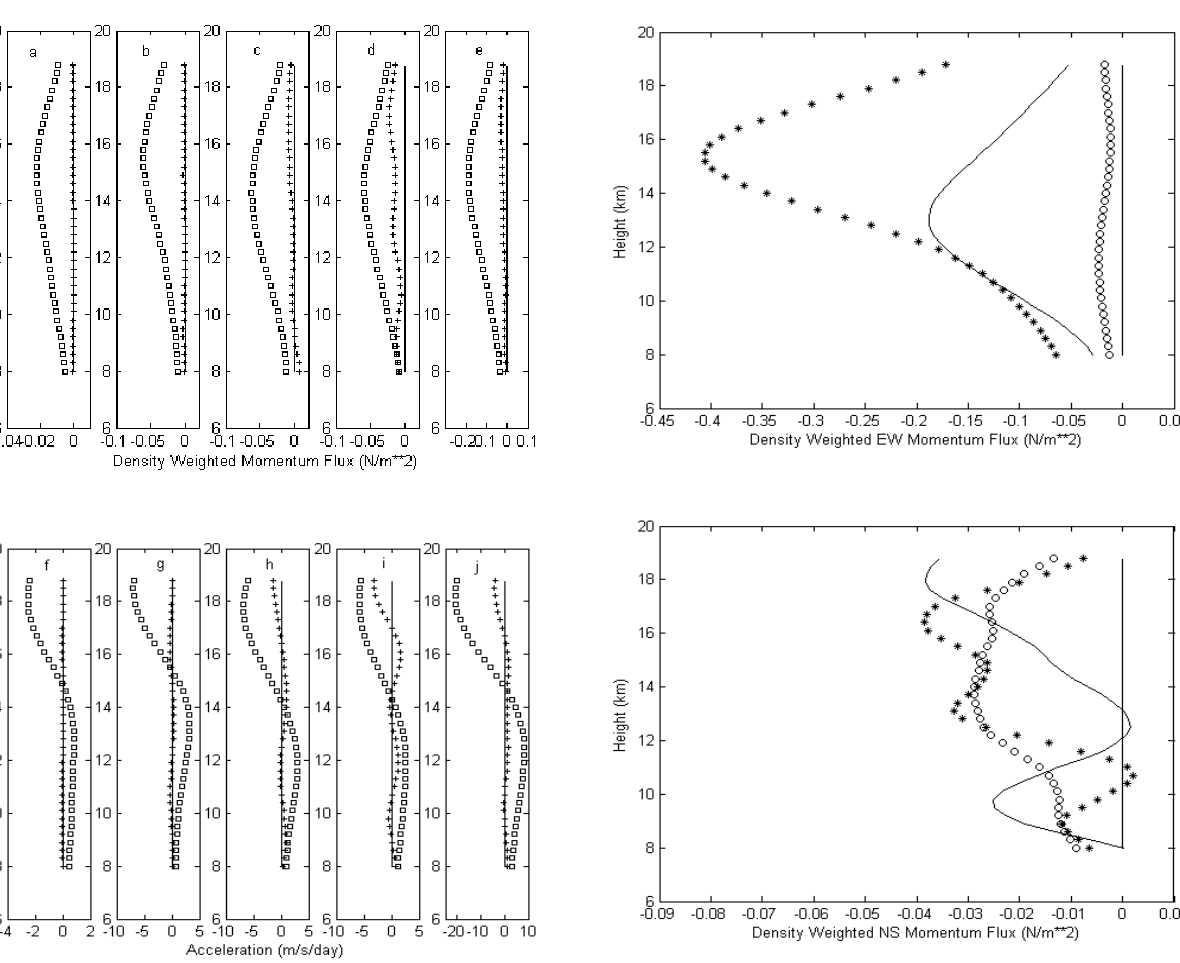
Fig. 8b. Daily average profiles of density weighted zonal mo- (cid:16) (cid:17) + u 0 Fig8b Daily average profiles of density weighted zonal momentum flux (upper panel) and u 0 w 0 w 0 Fig. 8a. Profiles of 72h averaged ρ 0 (square, ( ) mentum flux (upper panel) and meridional momentum flux (lower U U D D wuwu ′′+′′ ρ (square, zonal momentum) and Fig.8a Profiles of 72 hours averaged 0 DDUU (cid:16) (cid:17) meridional momentum flux (lower panel) in the 10min- 24 h band. The 1 st day fluxes panel) in the 10min–24h band. The 1st day fluxes were denoted by ( ) + v 0 v 0 w 0 w 0 zonal momentum) and ρ 0 (cross, meridional mo- wvwv ′′+′′ ρ (cross, meridional momentum) for periods of (a) 10- 30 min, (b) 30 U U D D 0 DDUU “circle”, 2nd day fluxes by “line”, and 3rd day by “star”. Notice that were denoted by ‘circle’, 2 nd day fluxes by ‘line’, and 3 rd day by ‘star’. Notice that the mentum) for periods of (a) 10–30 ˙min, (b) 30min–2h, (c) 2–7h, min– 2 h, (c) 2- 7 h, (d) 7- 24 h, and (e) 10 min- 24 h. Shown in (f) – (j) are the the scale of zonal component is 5 times of the scale of meridional scale of zonal component is 5 times of the scale of meridional component. (d) 7–24h, and (e) 10min–24h. Shown in (f–j) are the correspond- corresponding inferred accelerations. The vertical straight lines are reference lines for ing inferred accelerations. The vertical straight lines are reference zero momentum flux (upper panel) and zero acceleration (lower panel). lines for zero momentum flux (upper panel) and zero acceleration (lower panel).